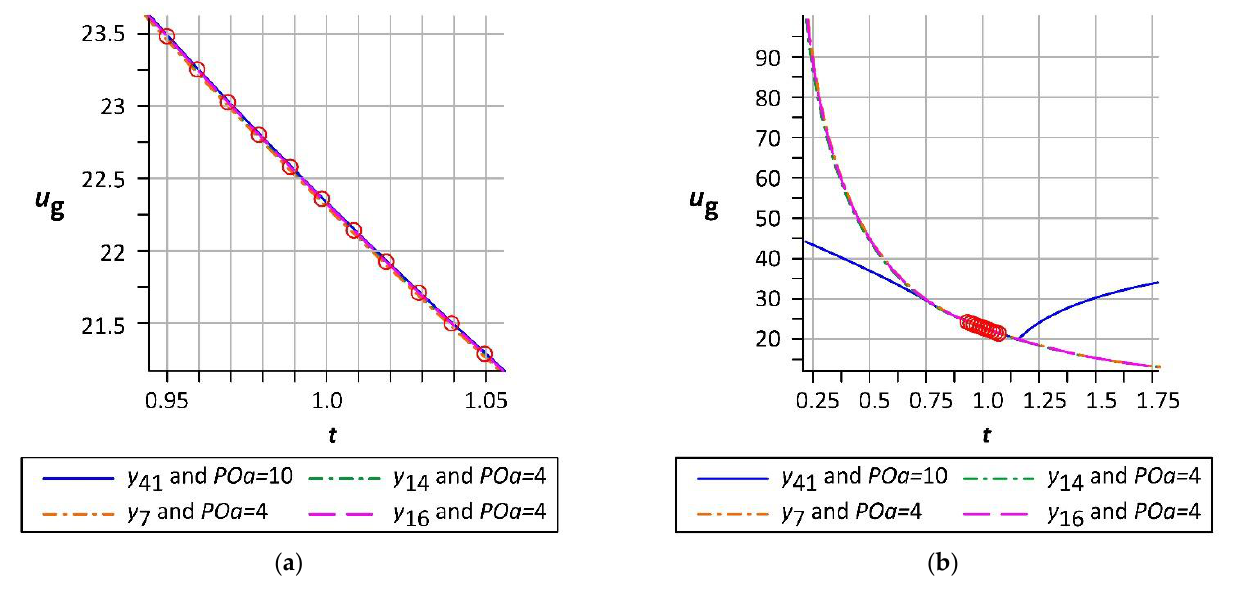
Figure 17. Comparison of several approximations with the maximum mean of the RMSE mod values on the example of extreme global deflection data of the OB model with random wall thickness: ( a ) FEM tests range, ( b ) three-sigma range.